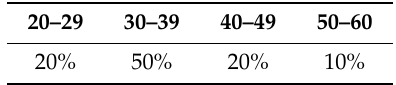
Table 4. Division of tested persons based on